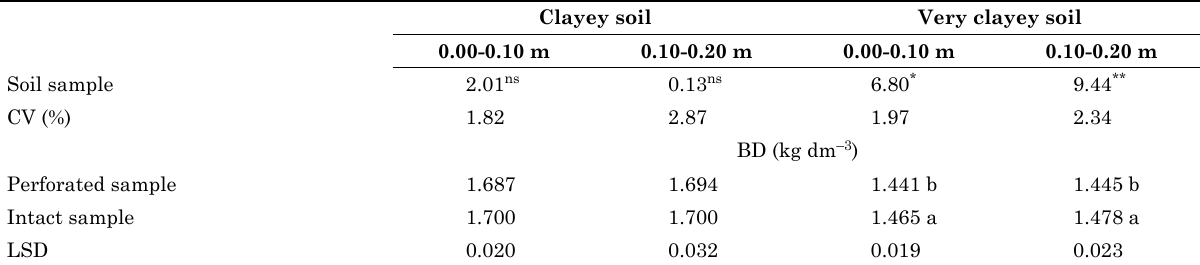
table 2. analysis of variance for bulk density (Bd) values in the 0.00-0.10 and 0.10-0.20 m layers in soil with clayey and very clayey soil